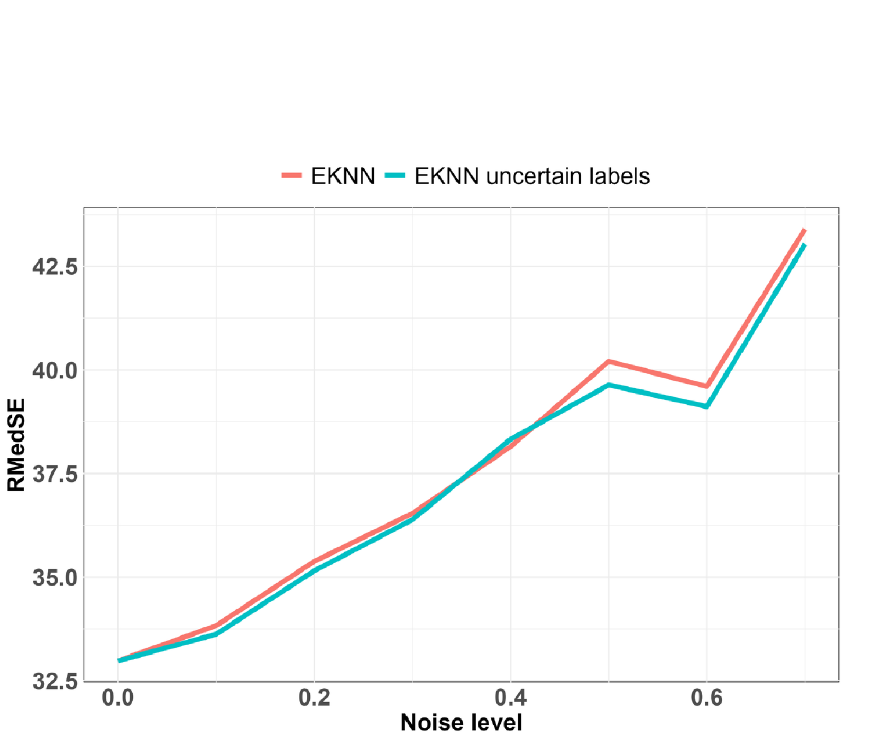
Fig 6. Predictive performances relative to noise levels for data imputed with CMA imputation method: K = 20: q =